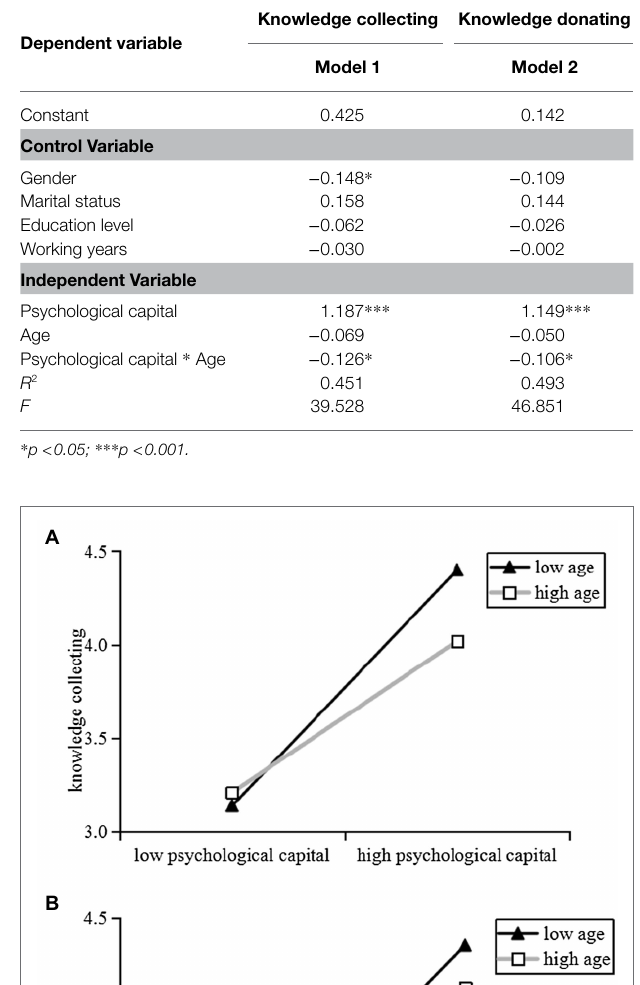
TABLE 3 | Moderating effect analysis.